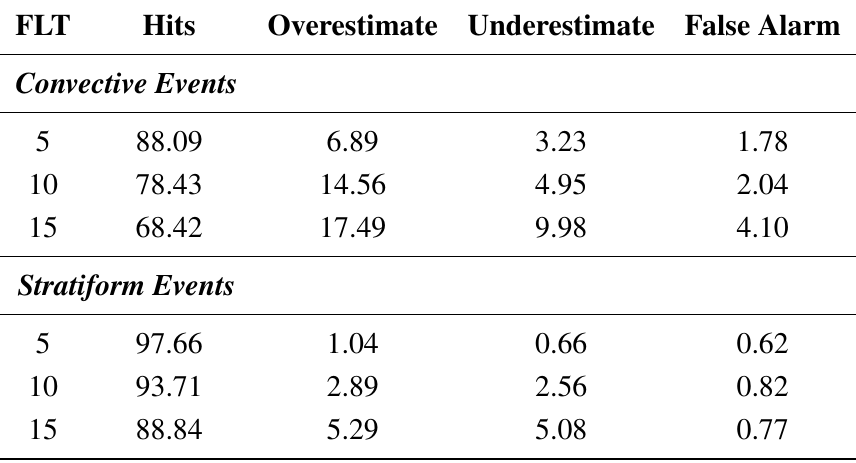
Table 7. Forecast evaluation for reflectivity estimation. All measures shown as a